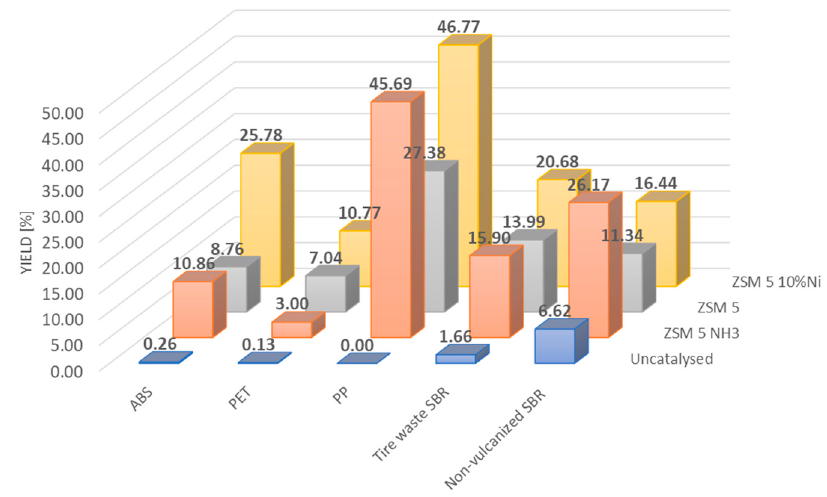
Figure 4. BTEX yield as a function of material and catalyst ratio (based on [19]).